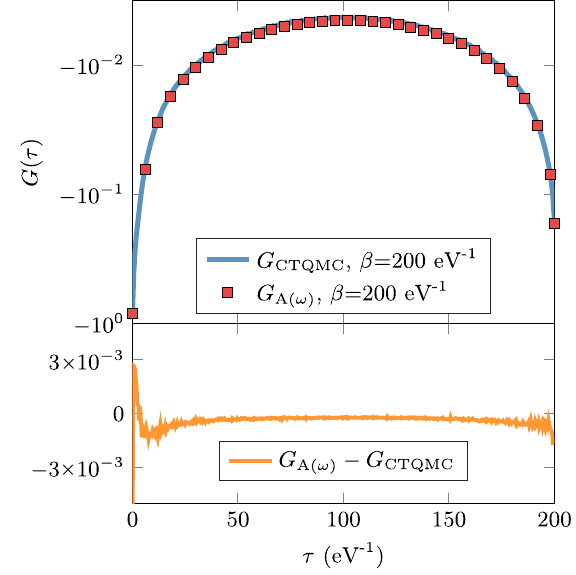
FIG. 6. Comparison of imaginary-time Green ’ s functions G ð τ Þ from CTQMC (G , blue line) and FTPS using Eq. (15) CTQMC (G , red squares). The agreement is also equally good at β ¼ A ð ω Þ 100 eV − 1 and β ¼ 400 eV − 1 (not shown). The difference be- tween the two Green ’ s functions is shown in the bottom panel. Note that on both ends, G is smaller than G . The A ð ω Þ CTQMC normalization of the spectral function demands that order of 10 − 2 from this constraint due to statistical noise, while FTPS gives (by construction) the correct result to a precision of 10 − 8 . This explains the bigger differences of the Green ’ s functions around τ ¼ 0 and τ ¼ β . For better visibility of the τ > 0 data, the value of 9 × 10 − 3 at τ ¼ 0 is not shown.